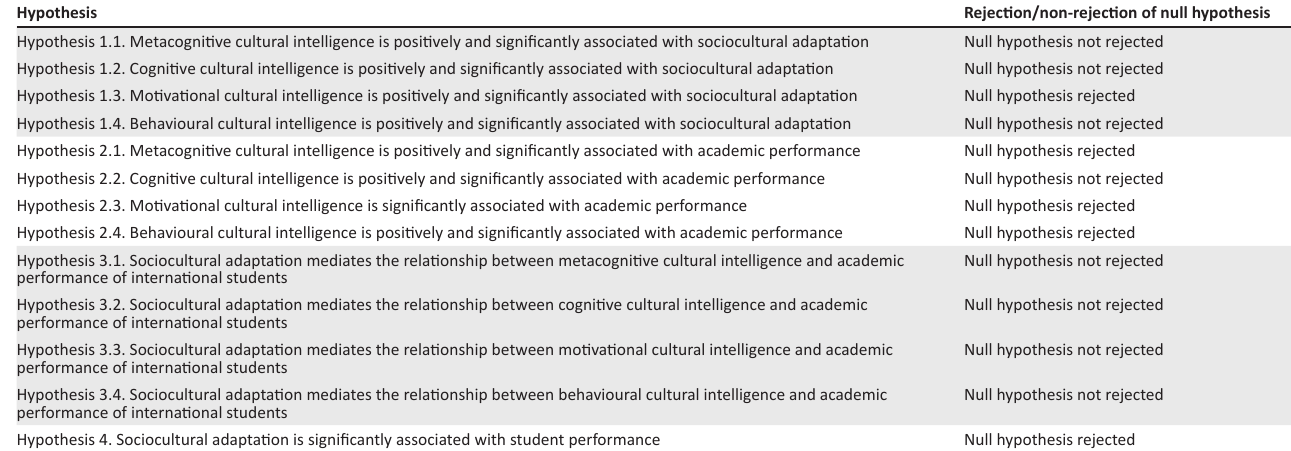
TABLE 4: Summary of hypothesis testing. Hypothesis Rejection/non-rejection of null